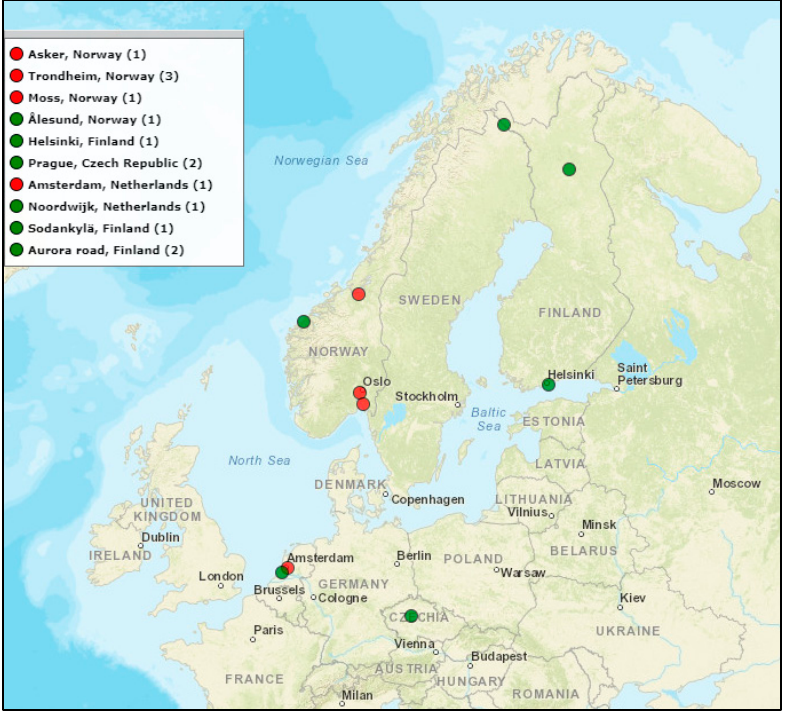
Figure 1. Locations of presently deployed RFI monitoring systems, with the number of sites indicated in brackets. Sites used in the analysis presented herein are shown in red.